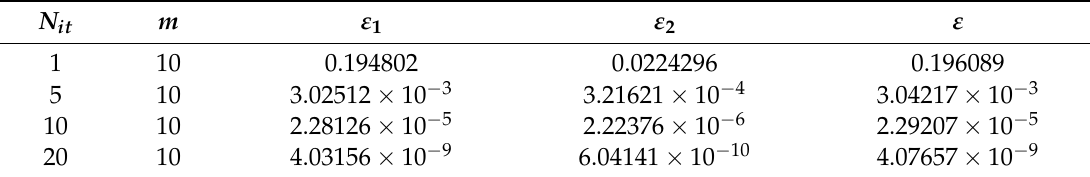
Table 6. Results for problem (32) for m =